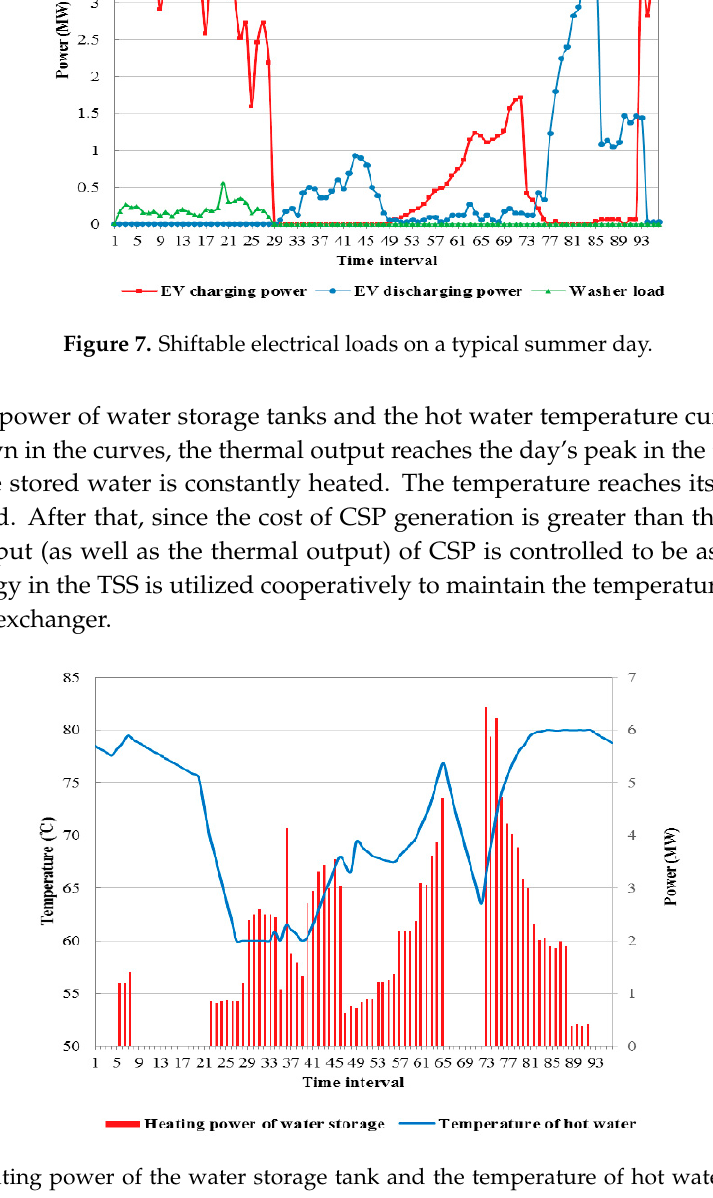
Figure 8. Heating power of the water storage tank and the temperature of hot water on a typical summer day.